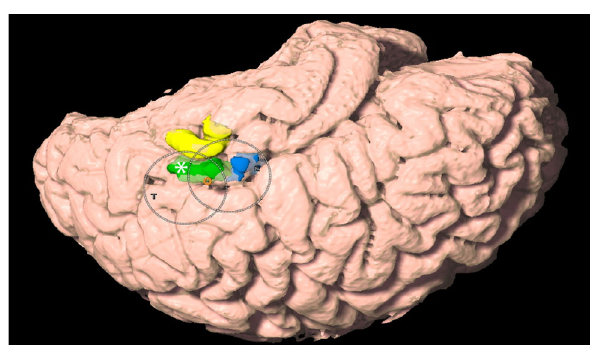
Fig. 2 Whole brain surface rendering showing the parcellated pathological areas divided by their connectivity to the fiber tracts. Green represents the area of direct connection of the lesion to the SLF via arcuate fascicle. (Color figure online)